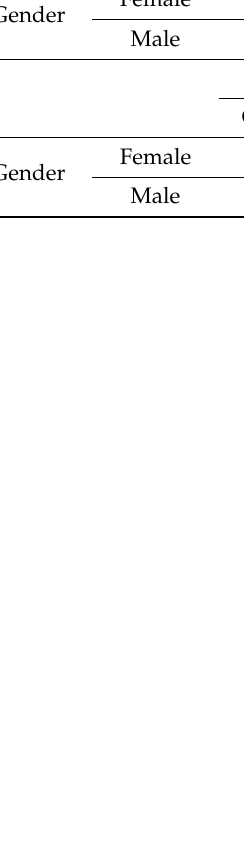
Table 4. How satisfied were you with your last shopping